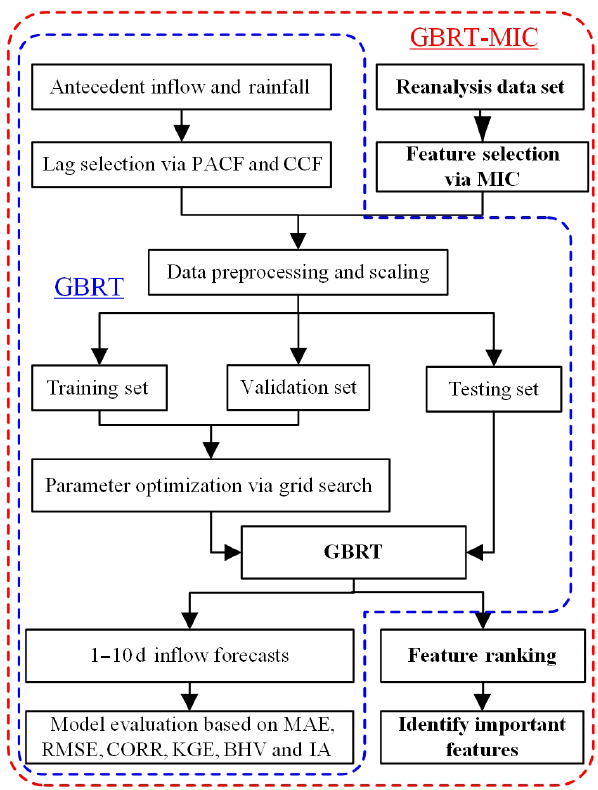
Figure 5. Overview of the